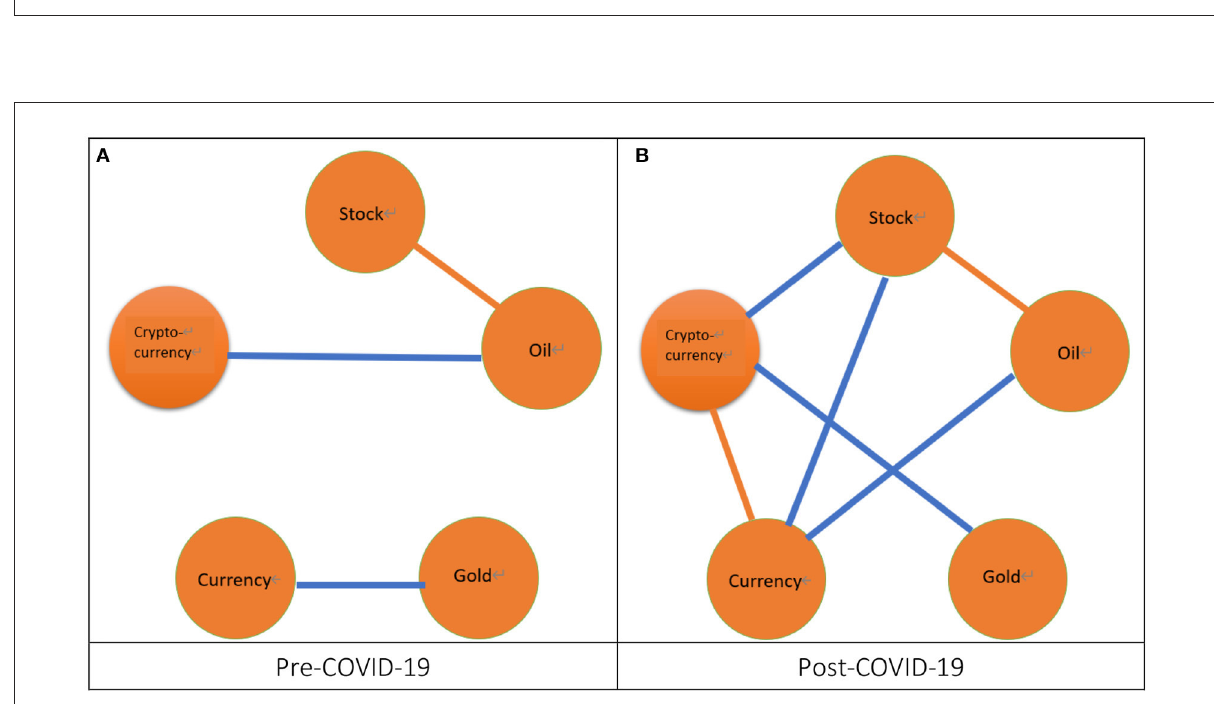
FIGURE4 The network of correlation. 1. The orange line connected by two nodes denotes a significant correlation between two markets represented by these two nodes. 2. The blue line connected by two nodes denotes a slightly significant correlation between two markets represented by these two nodes. (A) Pre-COVID-19 and (B)